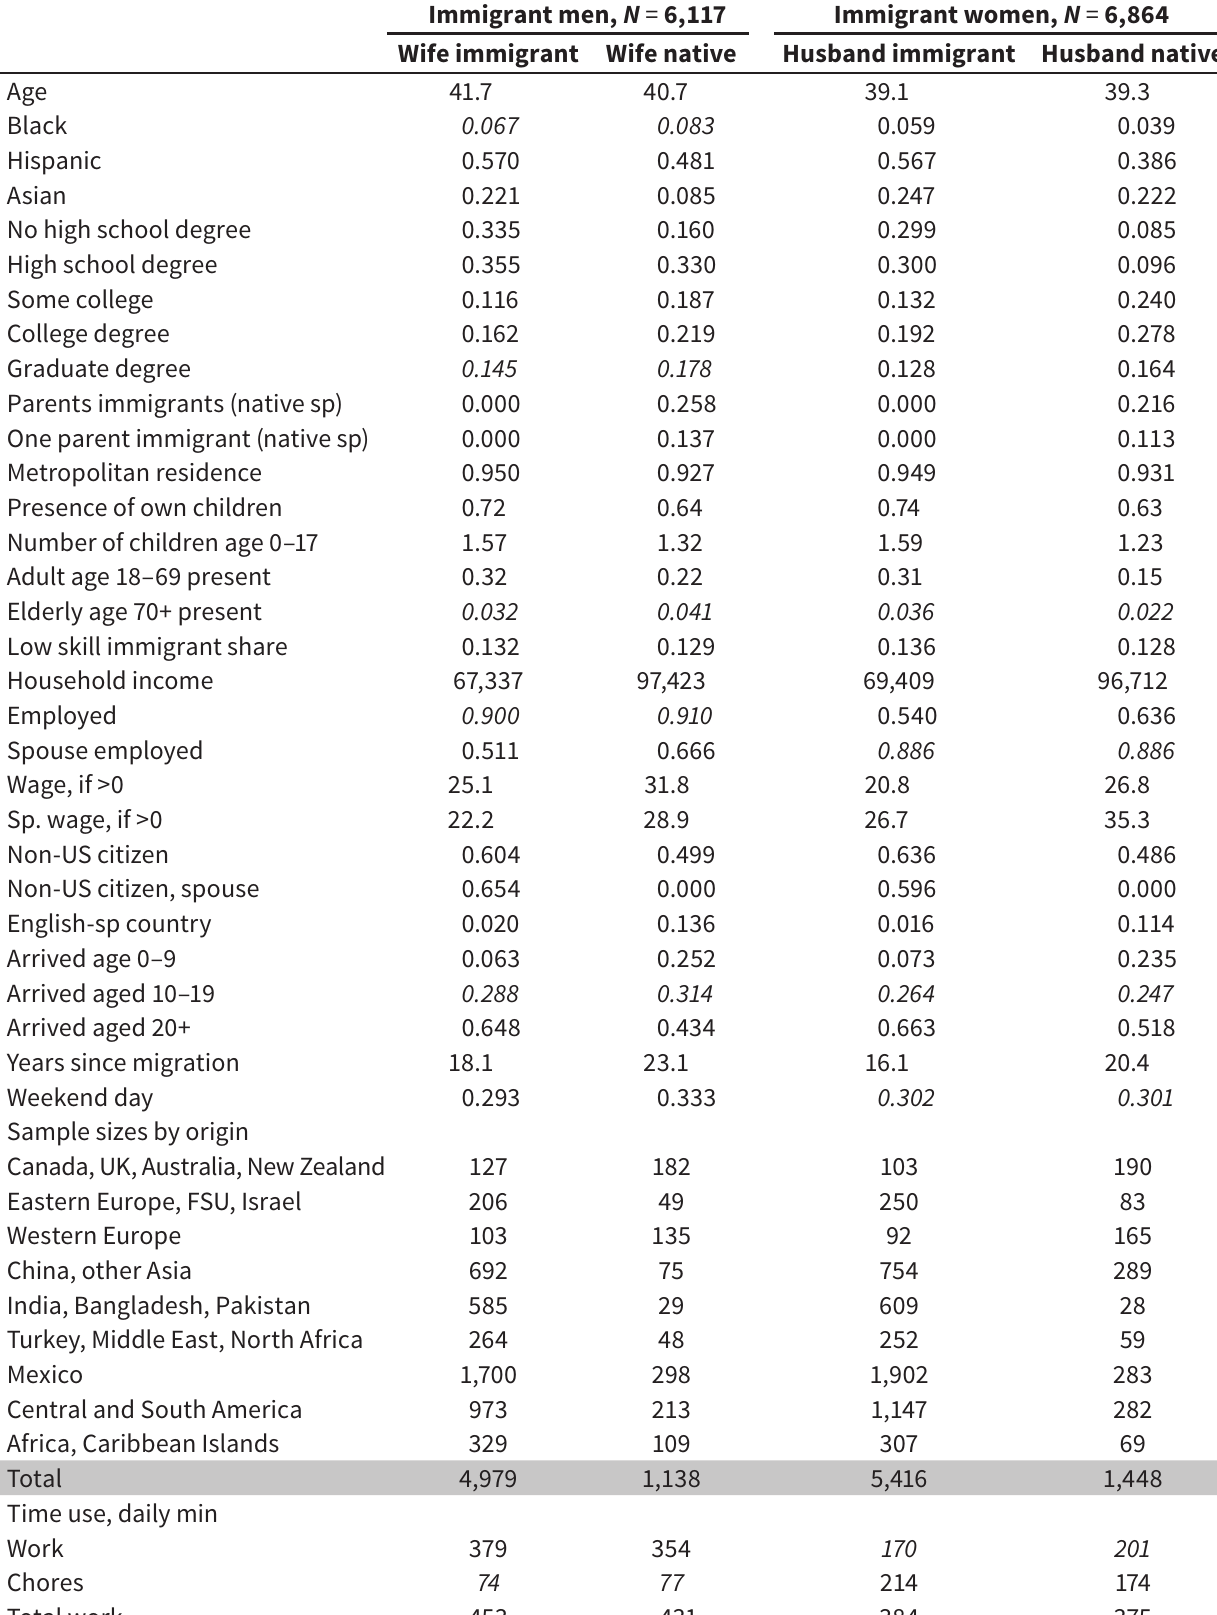
Sample means, married immigrants aged 20–60, ATUS